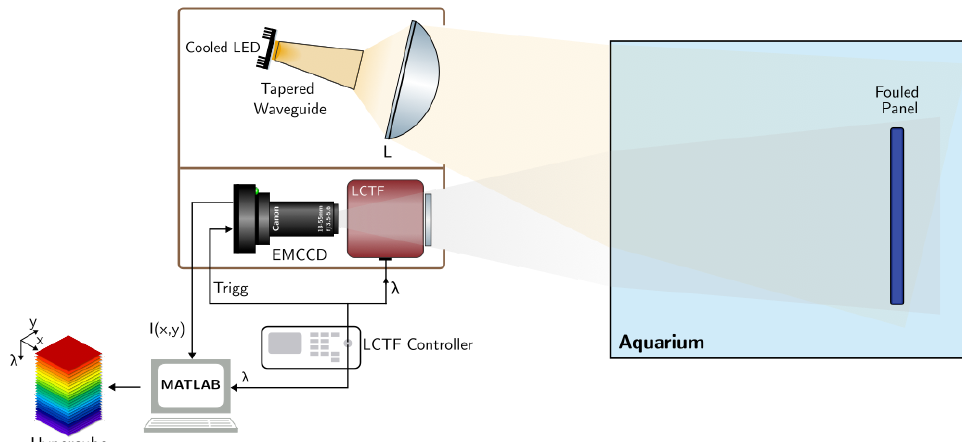
Figure 2. Schematic diagram of the developed hyperspectral imaging (HSI) system. A light-emitting diode (LED) was mounted on a cooling plate and coupled to a hollow tapered waveguide for light mixing and angle-to-area conversion. The uniform output of the waveguide was collected and re-imaged by an aspheric condenser lens (L) onto a coated panel mounted inside an aquarium filled with water. An electron-multiplying charge-coupled device (EMCCD) imaged the panel through a spectral-resolving and electrically-controlled liquid crystal tunable filter (LCTF). The hypercube was reconstructed using a custom computer program by stacking the wavelength-indexed 2D